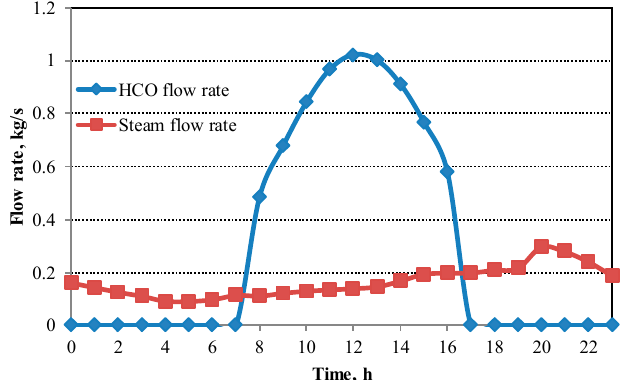
Figure 9. Variations in the flow rates of HCO and steam.